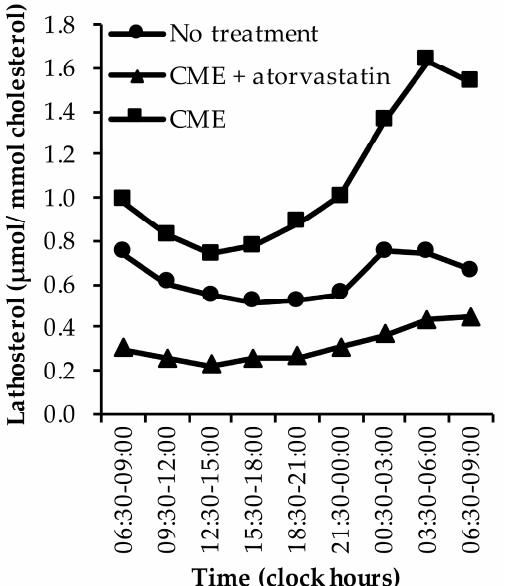
Figure 2. The diurnal rhythm of lathosterol levels in untreated subjects, in subjects treated with cholestyramine (CME) alone, and in subjects treated with CME plus atorvastatin [40,41,43]. Data are presented as medians.